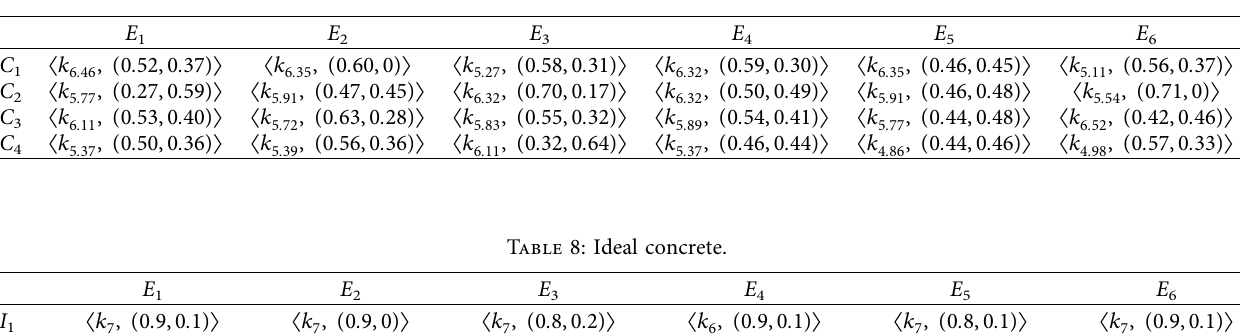
Table 7: Collective IL decision matrix.